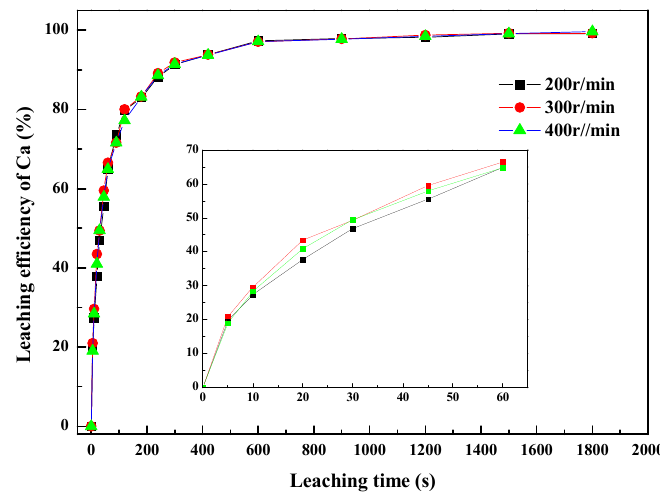
Figure 7. Effect of the stirring speeds on the leaching efficiency of calcium (C 0 = 0.20 mol/L, T = 25 °C, stirring speeds 400 r/min).